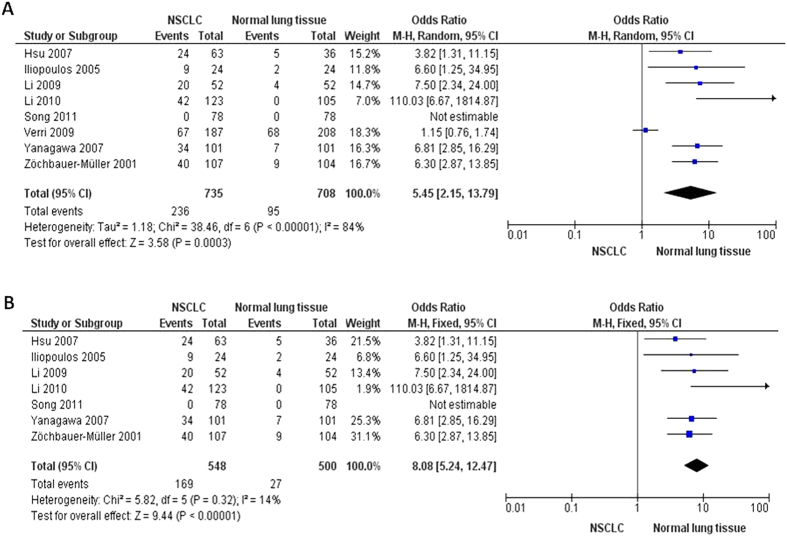
The pooled OR from 8 studies included 735 NSCLC and 708 normal lung tissues, I2 = 84%; OR = 5.45, 95% CI = 2.15–13.79, p = 0.0003.(A) The pooled OR from 7 studies included 548 NSCLC and 500 normal lung tissues, I2 = 14%; OR = 8.08, 95% CI = 5.24–12.47, p < 0.00001 (B).